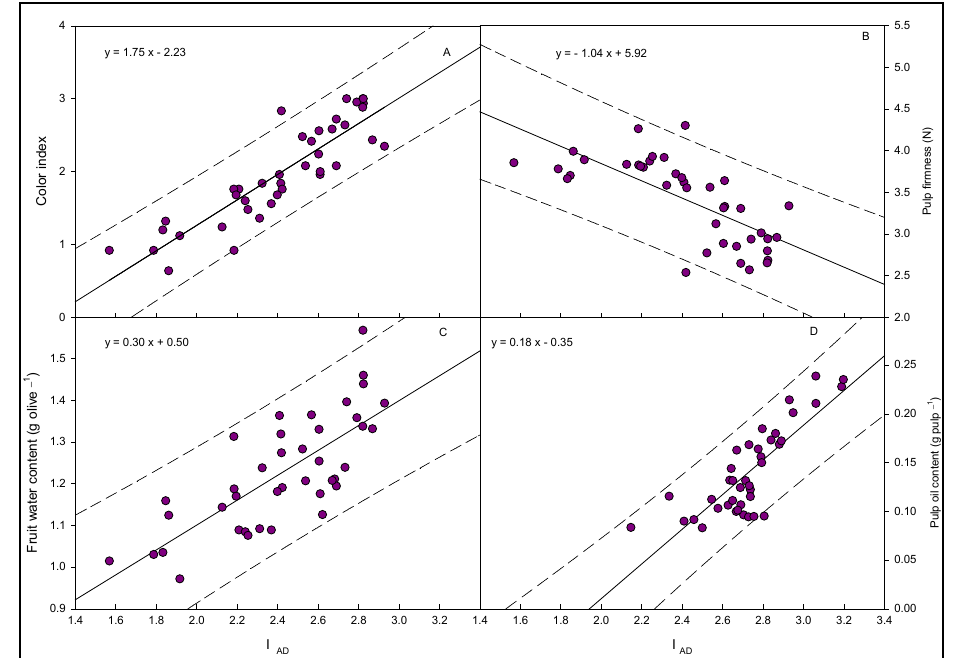
Figure 1. ( A ) Relationship between I AD and color index. ( B ) Relationship between I AD and pulp firmness. ( C ) Relationship between I AD and fruit water content. ( D ) Relationship between I AD and pulp oil content by Kiwi-Meter ® device. The solid black line represents the regression line and the upper and the lower lines represent the prediction intervals. Regression equation is reported on the top of each graph.